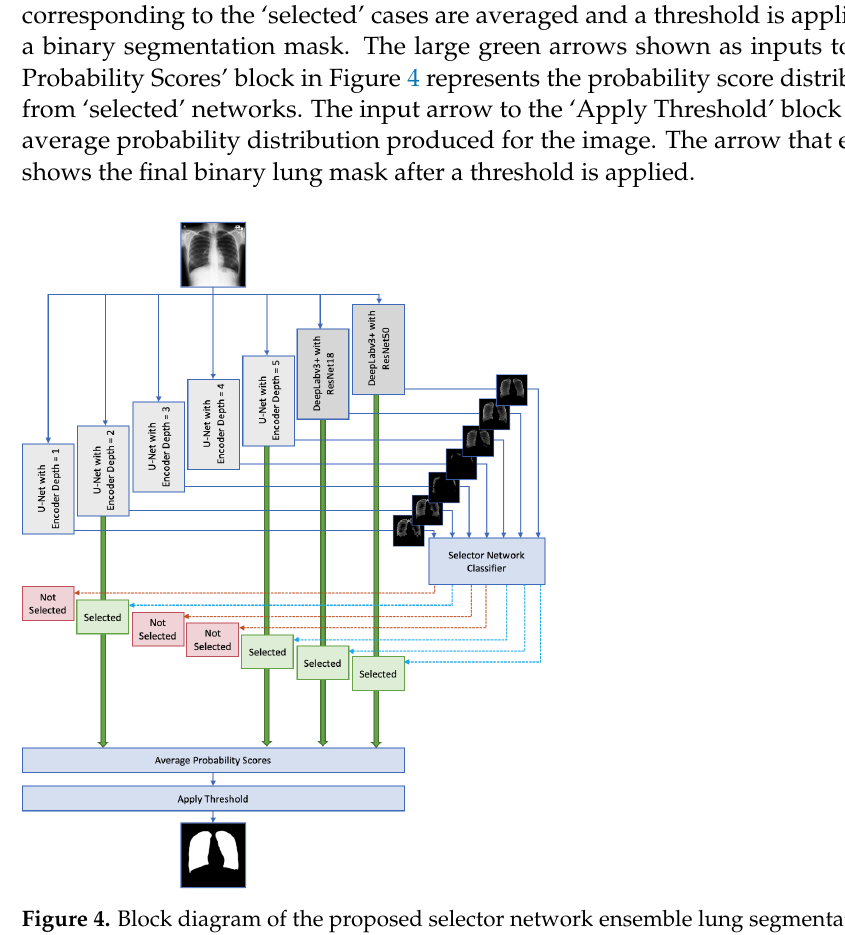
Figure 4. Block diagram of the proposed selector network ensemble lung segmentation